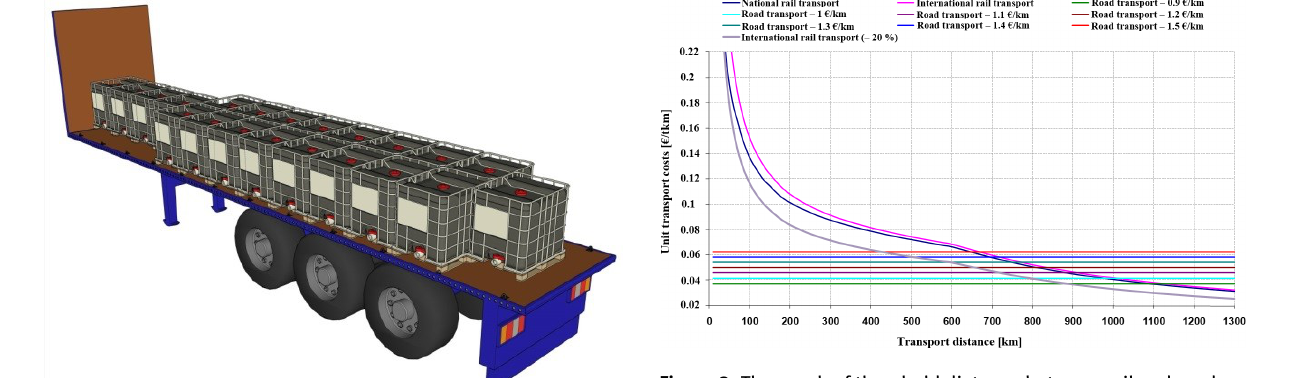
Figure 8: The graph of threshold distance between rail and